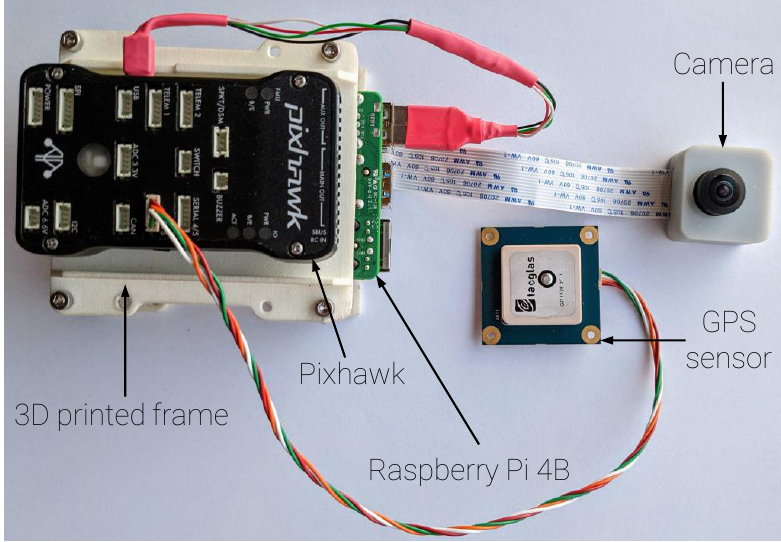
Figure 12. GSOE flight test